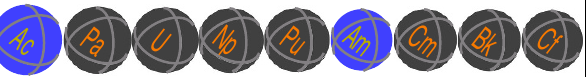
Figure 4 | MDDFT calculations. The calculated mean M–O H traces) and M–Cl (solid blue traces) distances for O and Cl atoms within 4Å of the metal (Am or Ac) have been compared with the values obtained from the experimental EXAFS analyses (M–O H dashed blue traces with their associated errors bars represented as shaded boxes). Experimental errors bars were 0.01 or 0.03Å. See Table 1. ( a ) Data for Am-Aquo , ( b ) Data for Am-HCl and ( c ) Data for